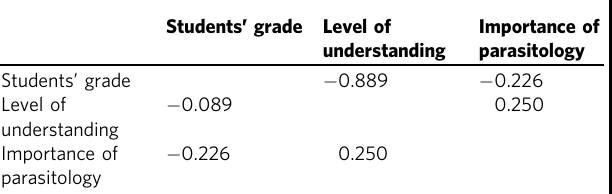
Table 4 Correlation coef fi cients between students ’ grade, level of understanding, and perception of the importance of